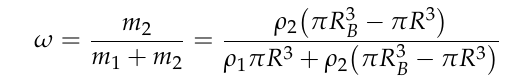
Figure 10. Hertz–Mindlin with Bonding contact model, where R 1 and R 2 are the practical radii of particles, mm; R 1 C and R 2 C are the contact radii between particles, mm; R B is the bonding zone radius between particles, mm.